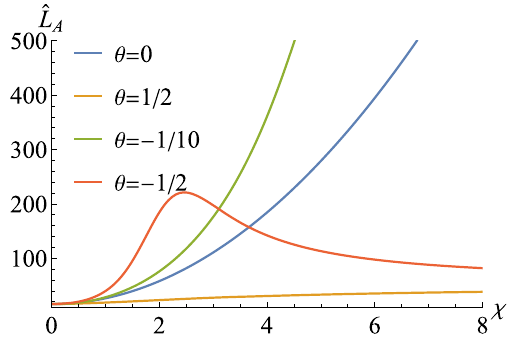
ˆ¯ L A as a function of χ for different θ . Here